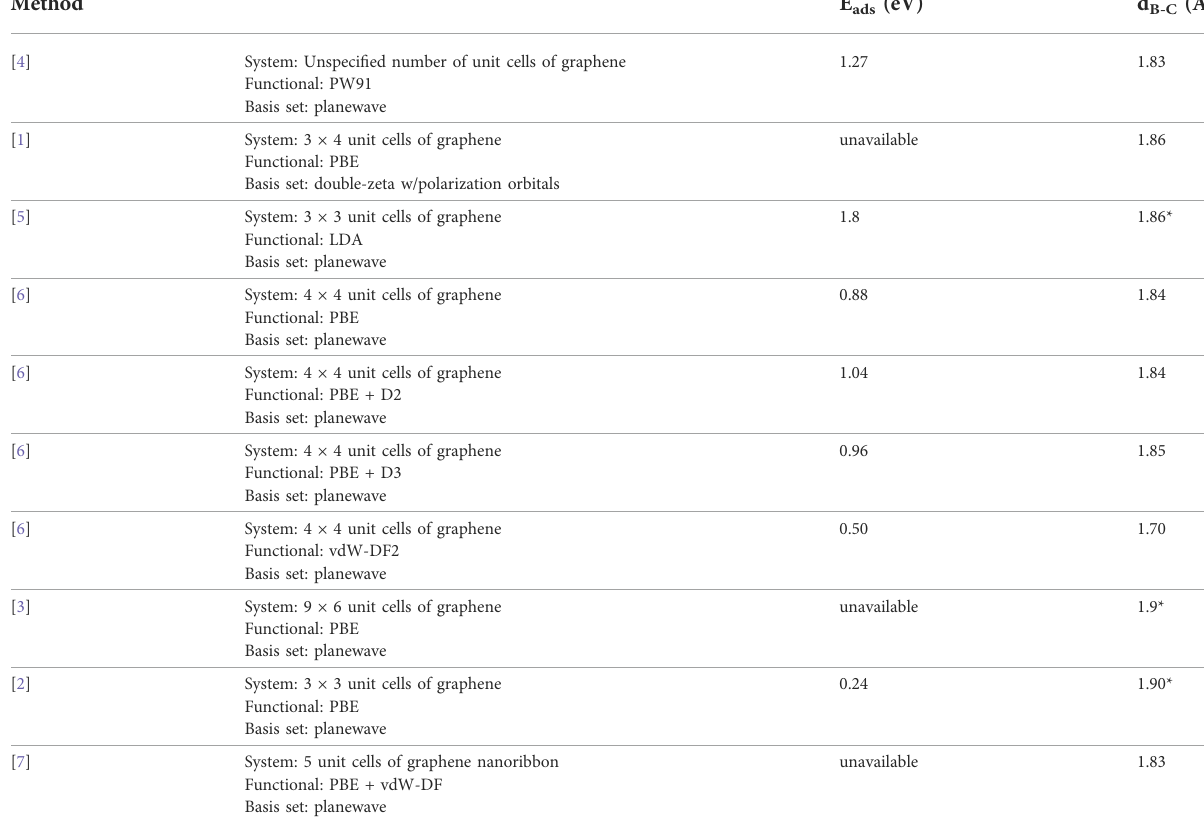
TABLE 1 Adsorption energies (E ads ) and nearest boron-carbon distances (d B-C ) for past DFT studies of atomic boron adsorbed on graphene and graphene-like surfaces. Distances marked with an * were inferred assuming a graphene C-C bond distance of 1.42 (cid:1) A.